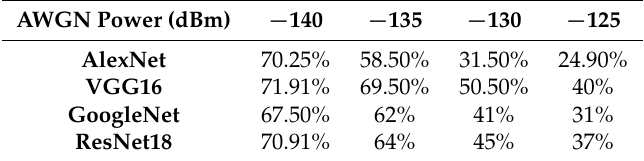
Table 5. The prediction result for AMC3.